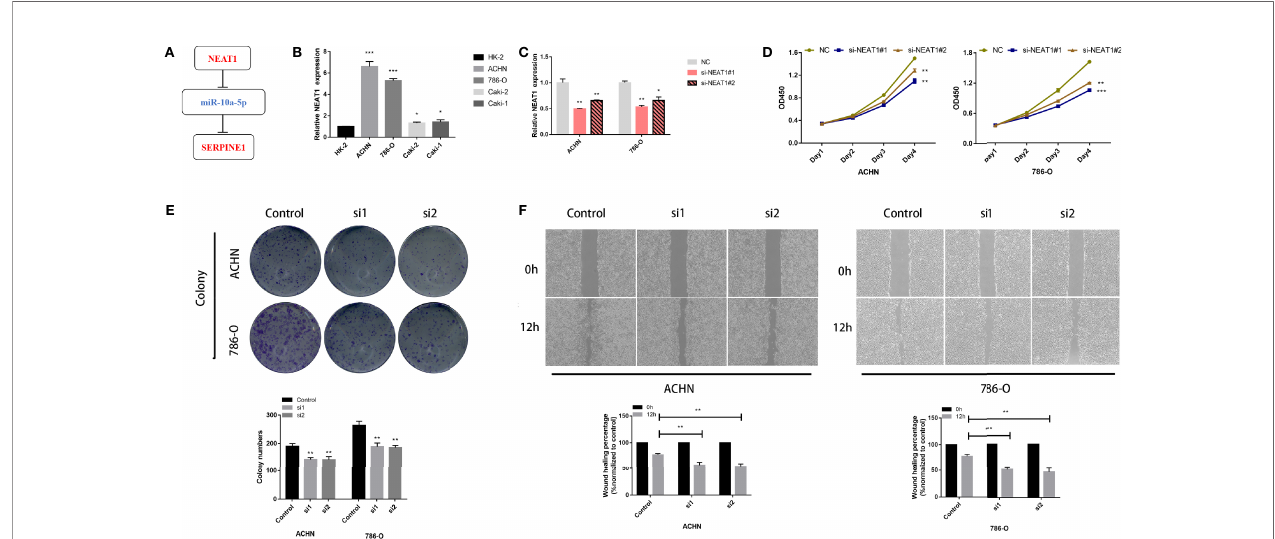
FIGURE 7 | LncRNA NEAT1 promotes proliferation and migration in kidney cancer cell lines. (A) Construction of a ceRNA axis; (B) NEAT1 is upregulated in kidney cancer cell lines; (C) Validation of knockdown ef fi ciency of siNEAT1 by RT-qPCR; Knockdown of NEAT1 inhibits proliferation (D) , colony formation (E) and migration (F) of kidney cancer cells. p ≥ 0.05; *p < 0.05; **p < 0.01; ***p < 0.001.